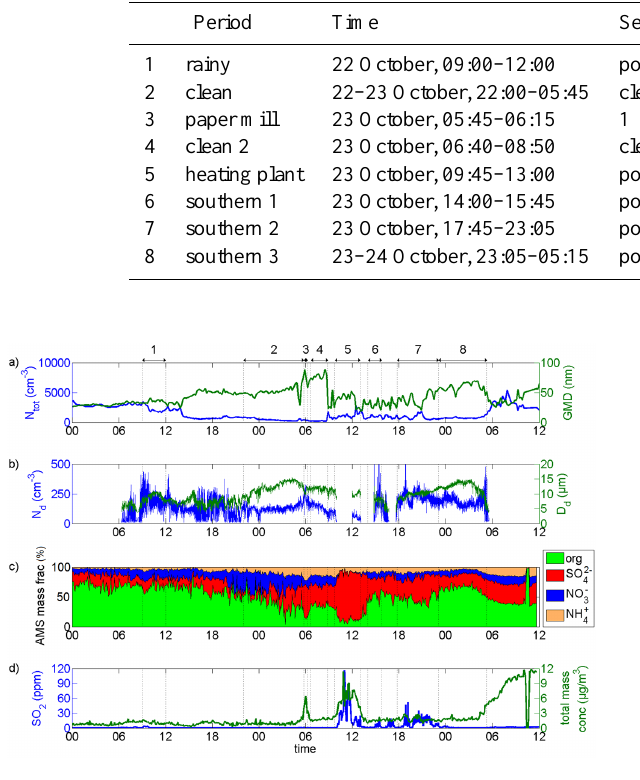
Figure 5. Time series during the cloud event on 22–24 October 2011 of (a) total particle number concentration (left axis) and geo- metric mean particle diameter (right axis), (b) cloud droplet number concentration (left axis) and mean droplet diameter (right axis), (c) mass fractions of different chemical components measured by the AMS and (d) SO 2 concentration (left axis) and total particle mass concentration measured by the AMS (right axis). Different periods described in the text are marked with dashed lines and also with numbered arrows above (a) (1, rainy; 2, clean; 3, paper mill; 4, clean 2; 5, heating plant; 6, southern 1; 7, southern 2; and 8, southern 3).